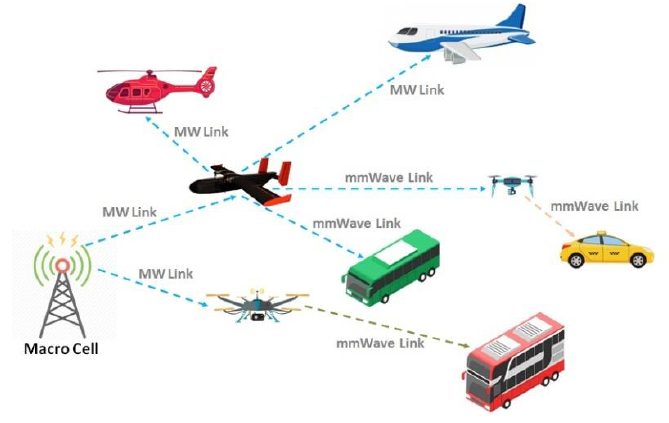
Fig 14. UAV Assisted Vehicular Communication Offshore Communication with